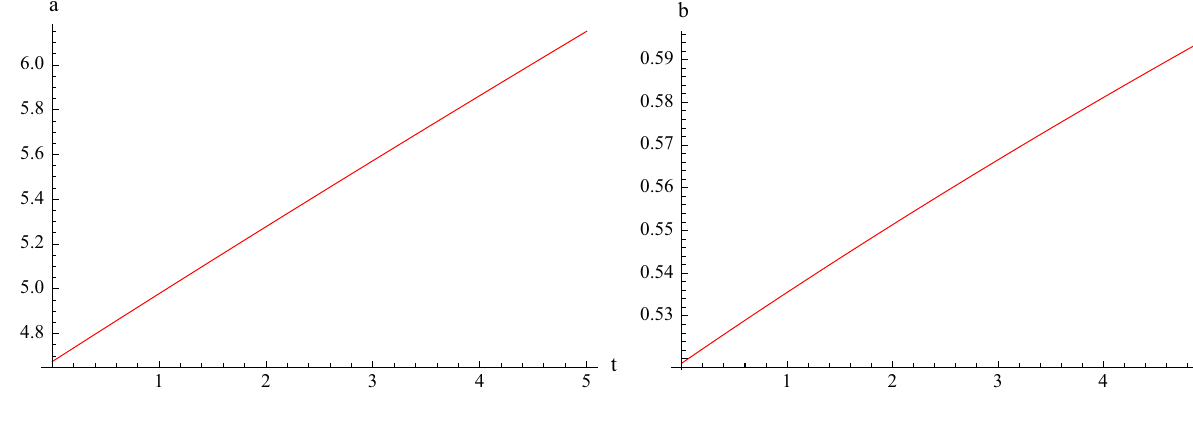
Fig. 1 Plots of scale factors a ( t ) ( left ) and b ( t ) ( right ) versus cosmic time t for c (cid:4)